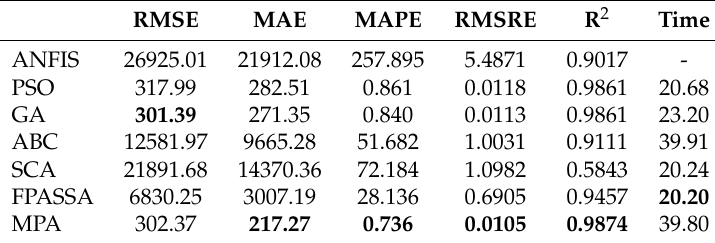
Table 4. Results of Iran.